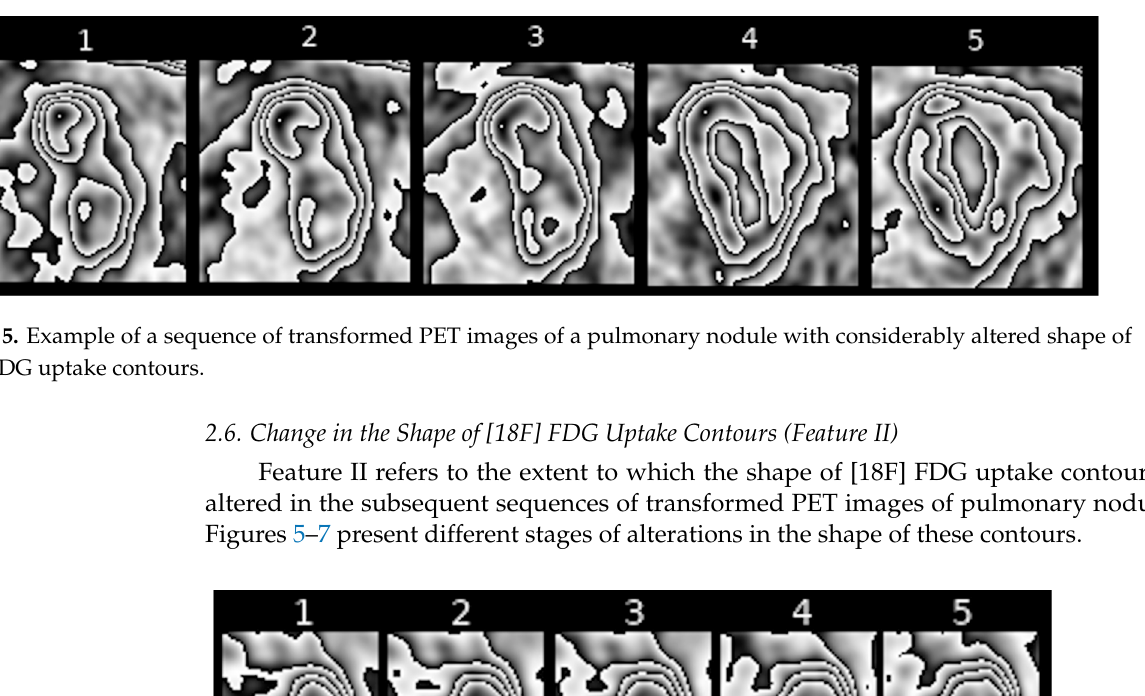
Figure 6. Example of a sequence of transformed PET images of a pulmonary nodule with moder- ately altered shape of [18F] FDG uptake contours.